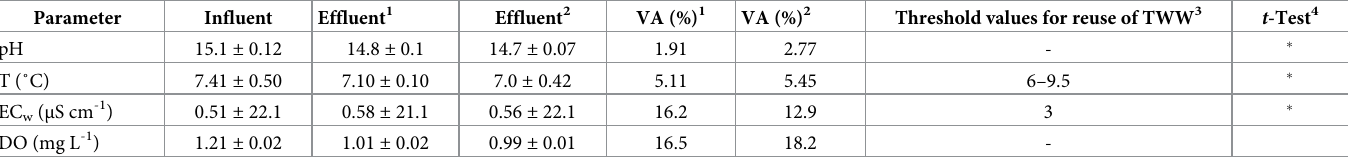
ent with respect to that recorded at the outlet. In particular, average effluent pH values were Table 1. Variation (VA) of pH, T and ECw in the two HSSFs CW units from April to September during 2016/2018. For each unit, three-year average values ( ± stan- dard deviation) are shown (n = 36).